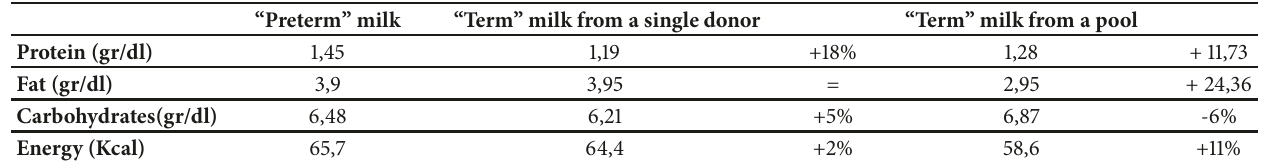
Table 5: Composition data